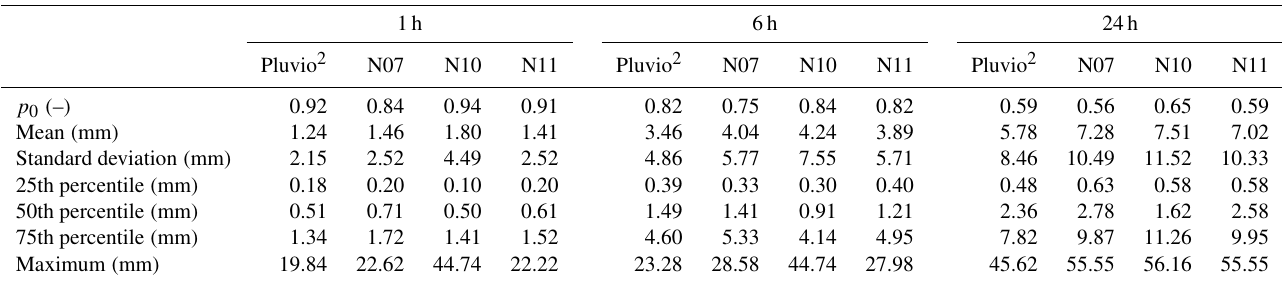
Table 1. Statistics of three Netatmo stations (N07, N10 and N11) compared to a Pluvio 2 weighing gauge for April to October 2019 at the IWS meteorological station for different temporal aggregations.